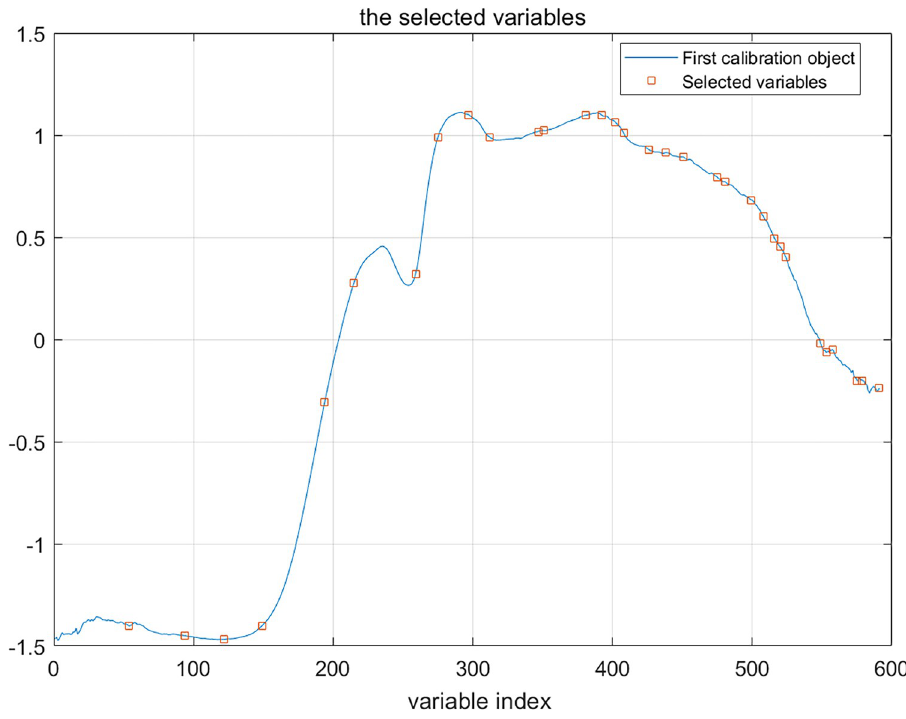
Fig 13. Map of SPA extracted characteristic wavelengths.